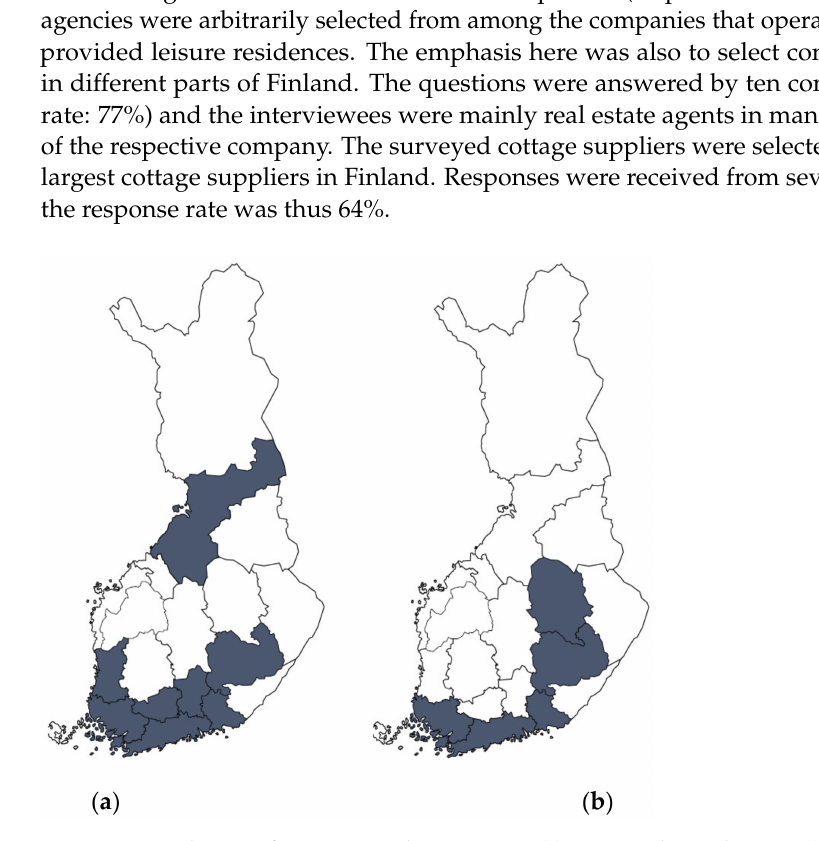
Figure 6. Distribution of interviewees by provinces: ( a ) municipal city planners; ( b ) building